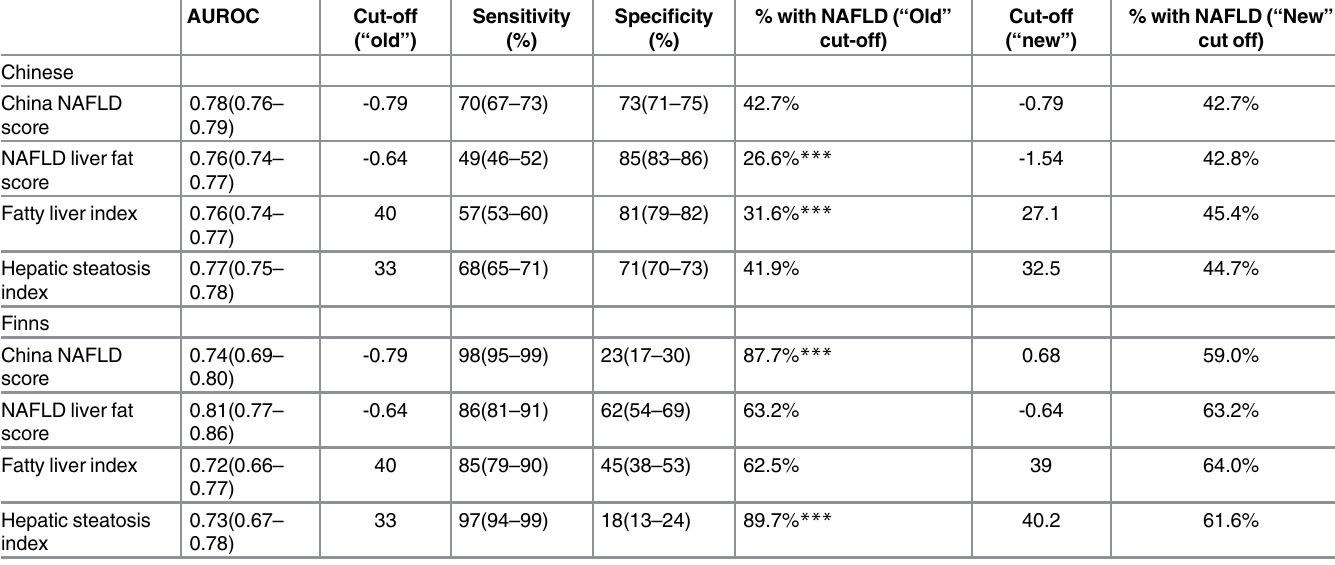
Table 4. Diagnostic performance of noninvasive prediction scores.